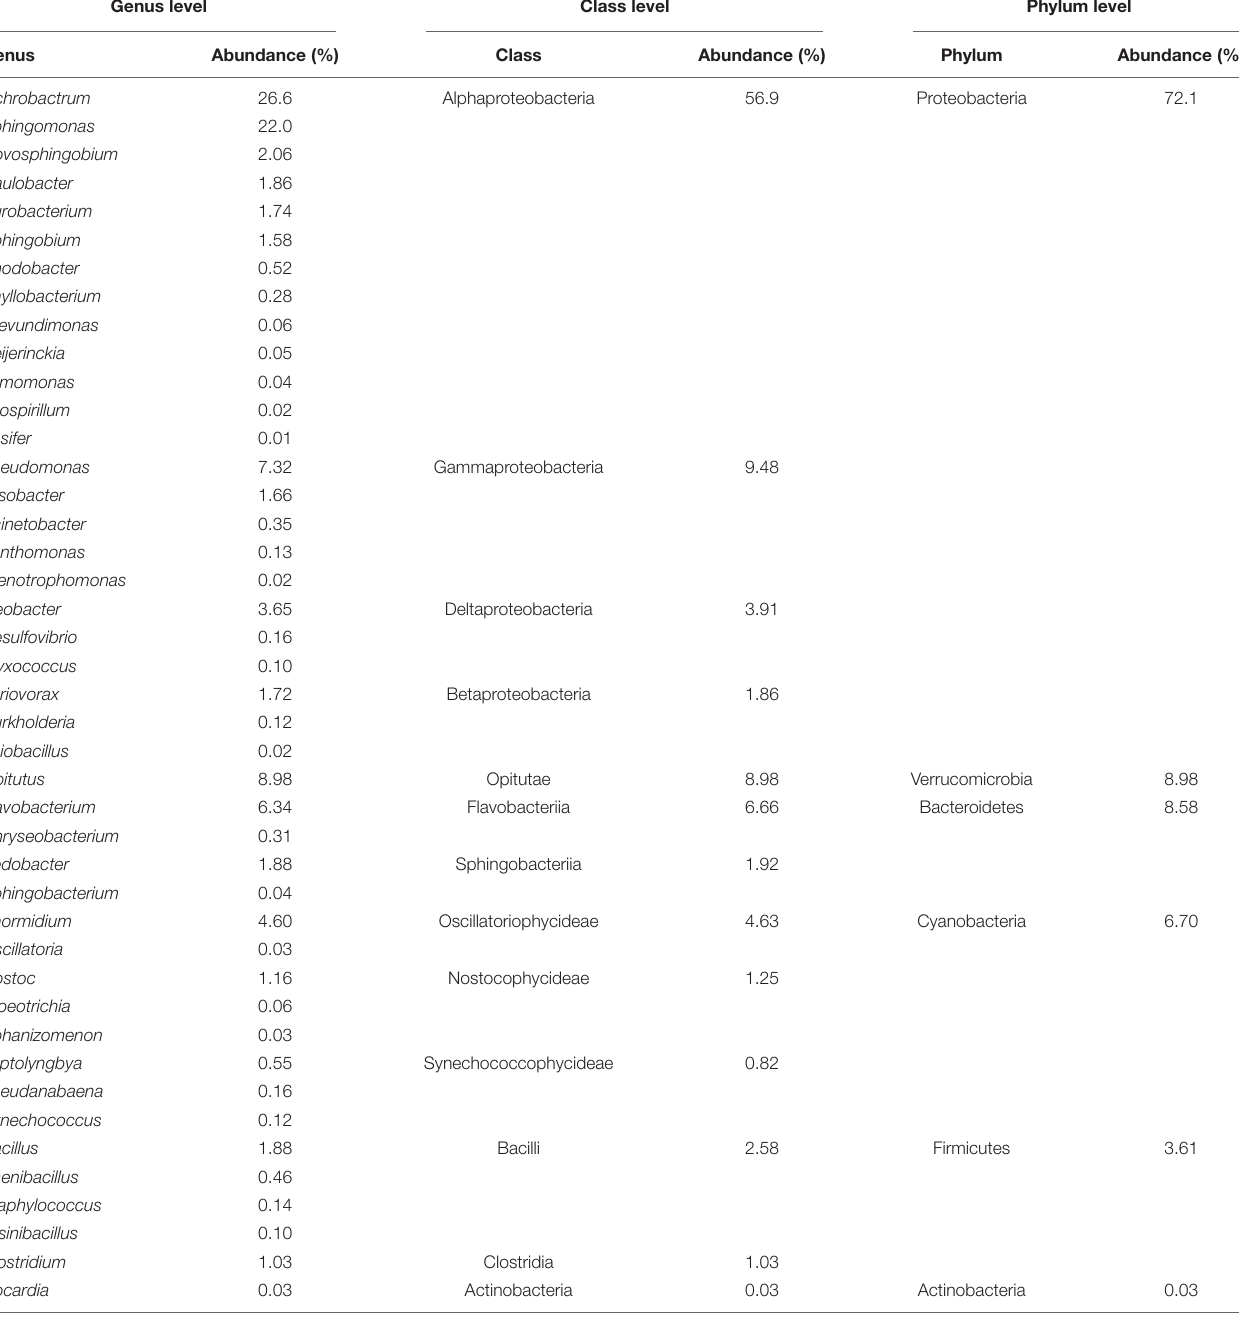
TABLE 3 | Composition and abundance of asymbiotic nitrogen-fixing microbial communities. Genus level